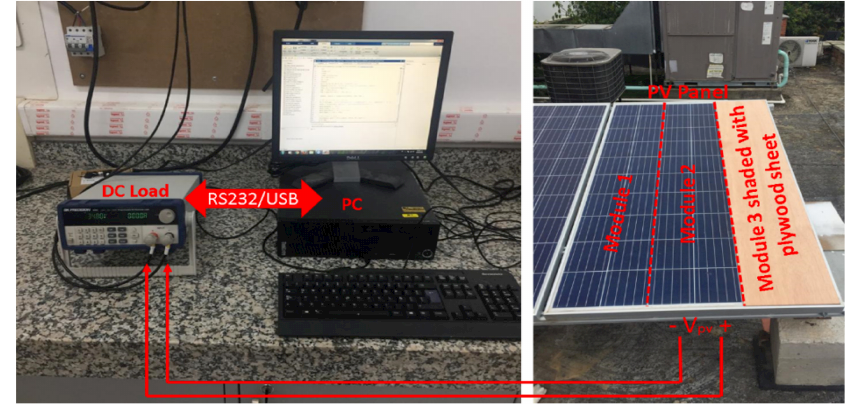
Figure 11. Experimental platform. Left : electronic load and PC in the laboratory. Right : PV module and piece of wood in the roof. Red lines from right to left represent the electrical connection between the module an the electronic